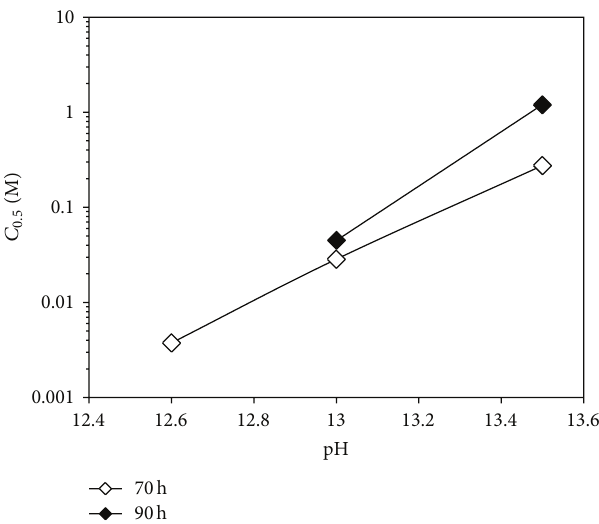
Figure4:EffectofpHoncriticalchloridecontentduringmultispec- imen potentiostatic tests.